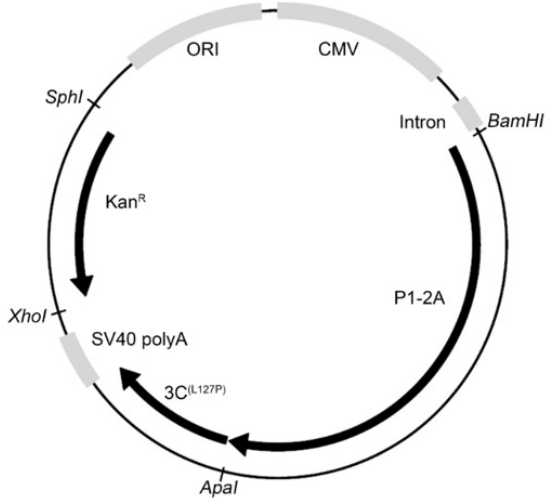
Figure 1. Plasmid map of a pJJPKan VLP expression plasmid containing the FMDV P1-2A and 3C (L127P) sequences in a single open reading frame. Restriction sites BamHI and ApaI are utilized to insert the P1-2A sequence from any desired serotype or strain into the plasmid.